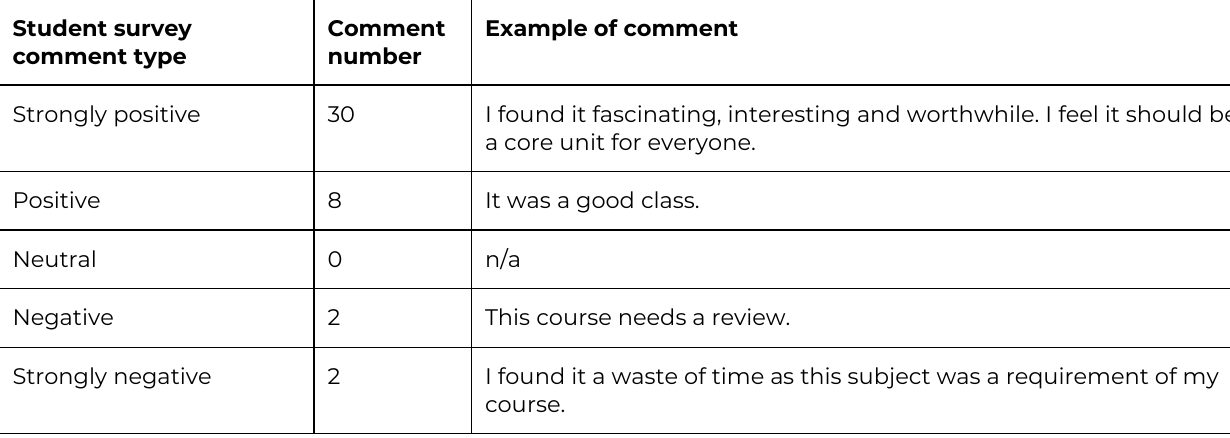
Table 3: Overview of comments Semester 2 2018 Student survey